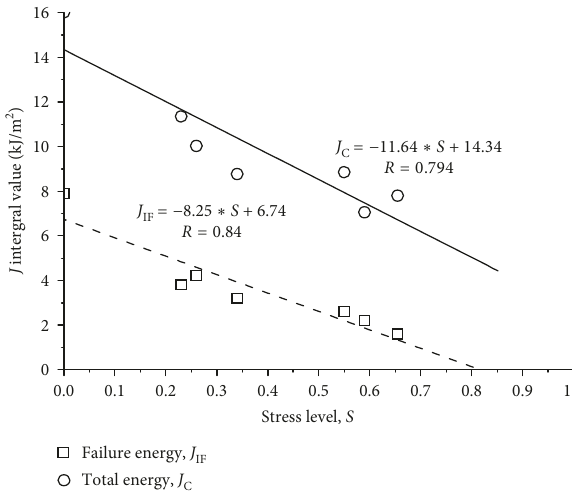
Figure 9: Relationship of the stress level and J